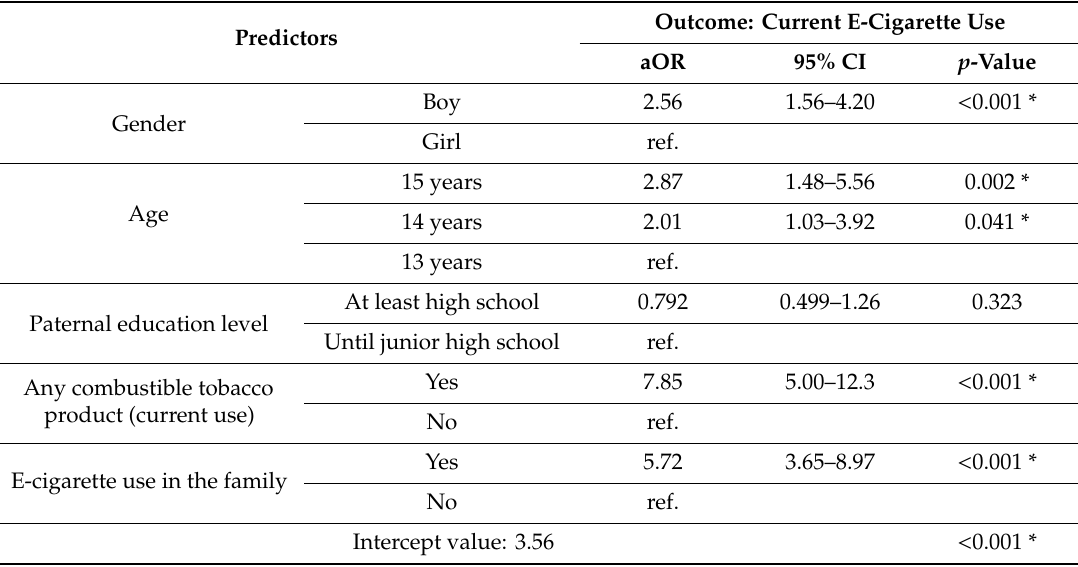
Table 4. Multivariable analysis of e-cigarette use (all